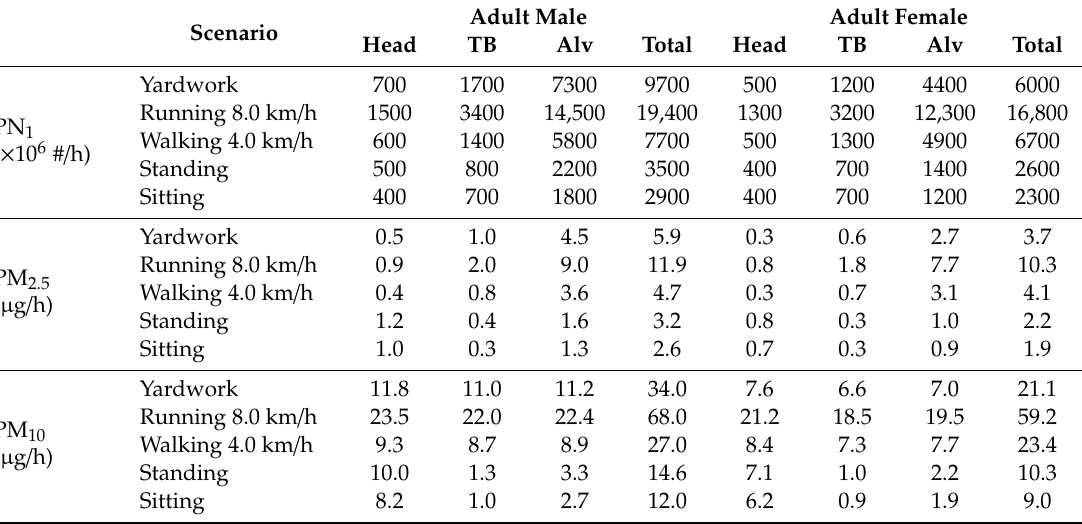
Table 4. Mean regional dose rates for aerosol exposure during indoor background conditions. Note that yardwork is assumed to be equivalent to housework and running is equivalent to indoor